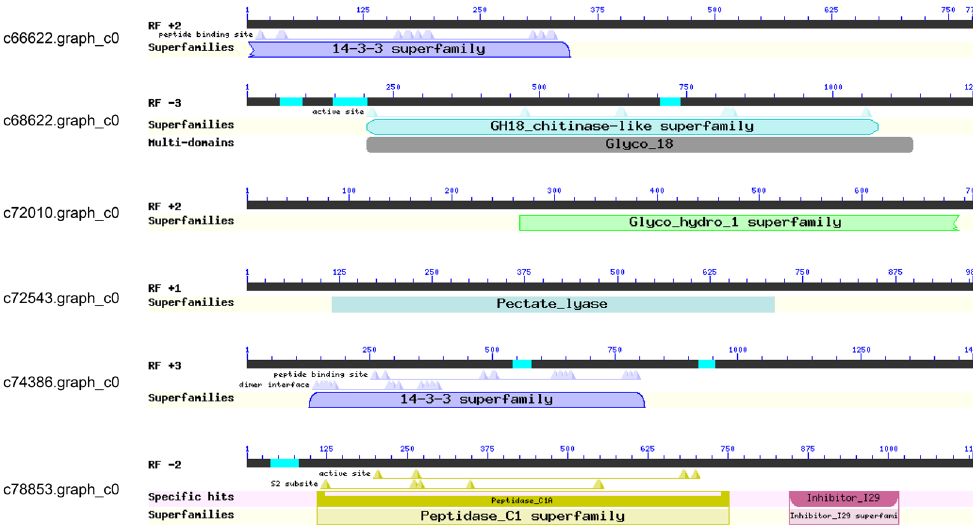
Figure 7. Structural domains of the six candidate effector genes of Heterodera avenae predicted through National Center for Biotechnology Information (NCBI). Both c66622.graph_co and c74386.graph_c0 contain a putative 14-3-3 domain; c68622.graph_c0 contains a GH18_chitinase-like domain or a glyco_18 domain; c72010.graph_c0 contains a putative glyco_hydro_1 domain; c72543.graph_c0 contains a putative pectate_lyase domain; and c78853.graph_c0 contains a peptidase_C1 domain and an inhibitor_I29 domain (cathepsin propeptide inhibitor domain (I29)).